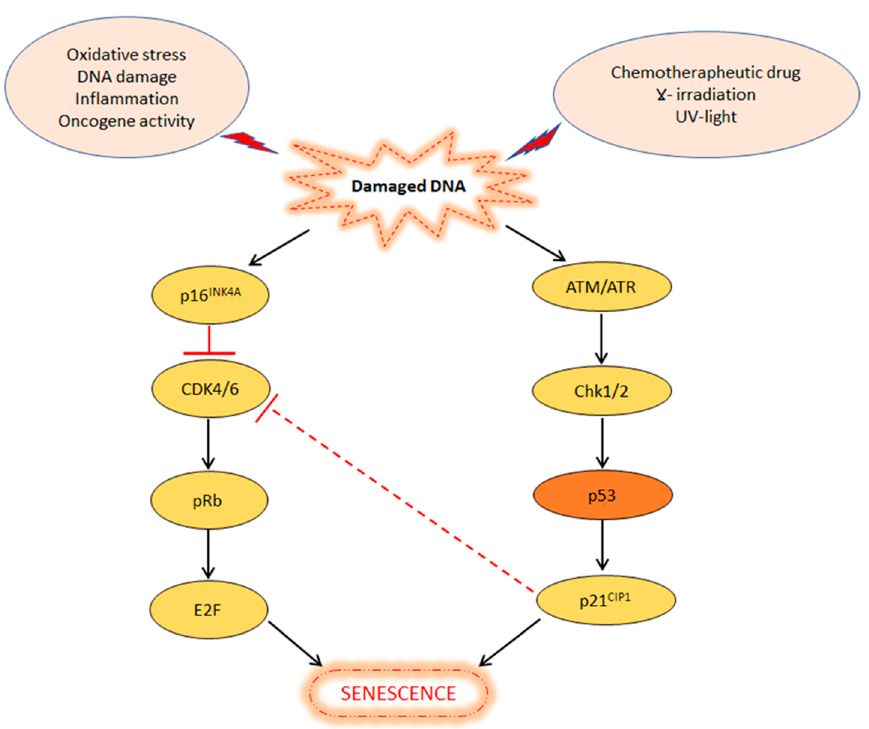
Figure 2. p53 and P16INK4A pathways in the induction of cellular senescence. Internal or external stress factors trigger the DNA damage response pathway. On one side, p16INK4A inactivates Cdk4/6, determining hypo-phosphorylation of Rb. On the other side, p53 induces p21, which blocks CDK4/6 or directly results in